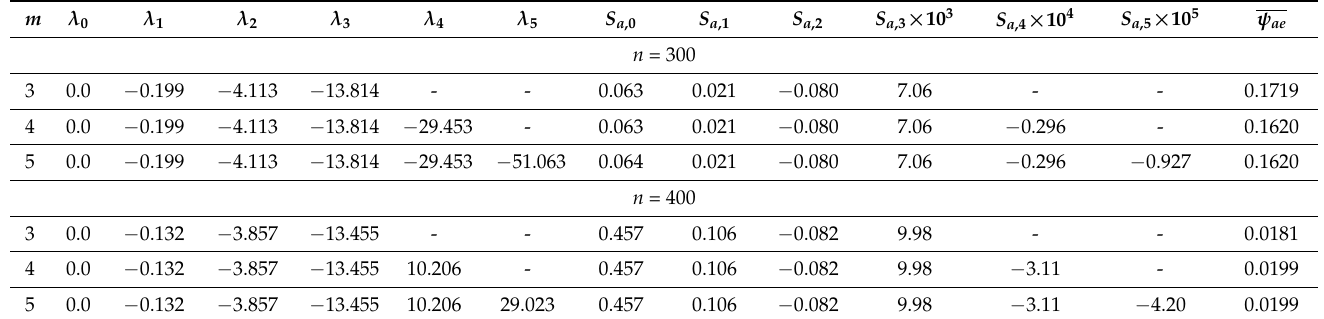
Table 1. The dimensionless outlet concentrations and the associated eigenvalues and expansion coefficients under countercurrent-flow operations with 19 fiber